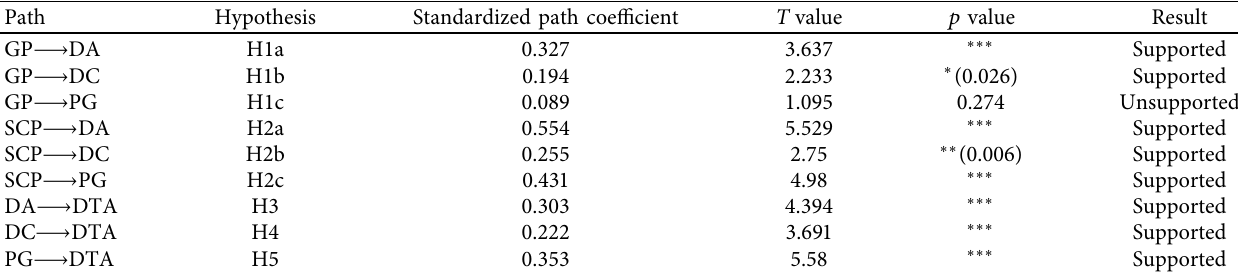
Figure 2: Standardized solution of structural modeling analysis. ∗ p -value < 0.05; ∗∗ p -value < 0.01; and ∗∗∗ p -value < 0.001. Table 4: Path coefficients and testing results of hypotheses.